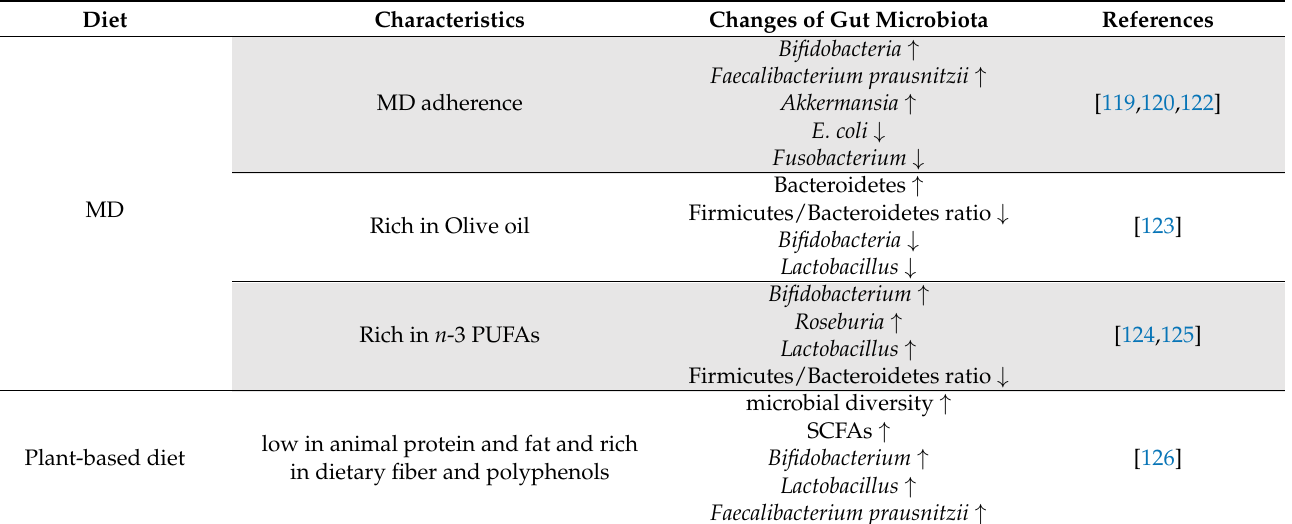
Table 3. Characteristics of the Mediterranean diet and plant-based diet and gut microbiota